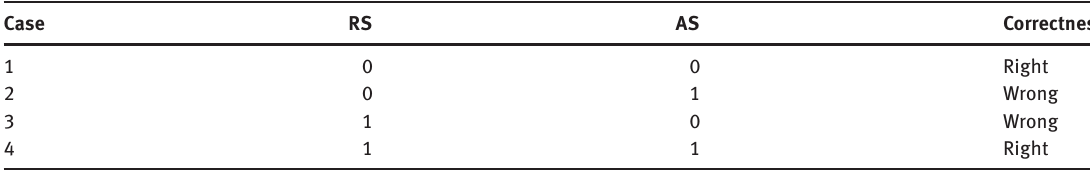
Table 5: Four Types of Neurons Divided by the Belonging of RS and AS.